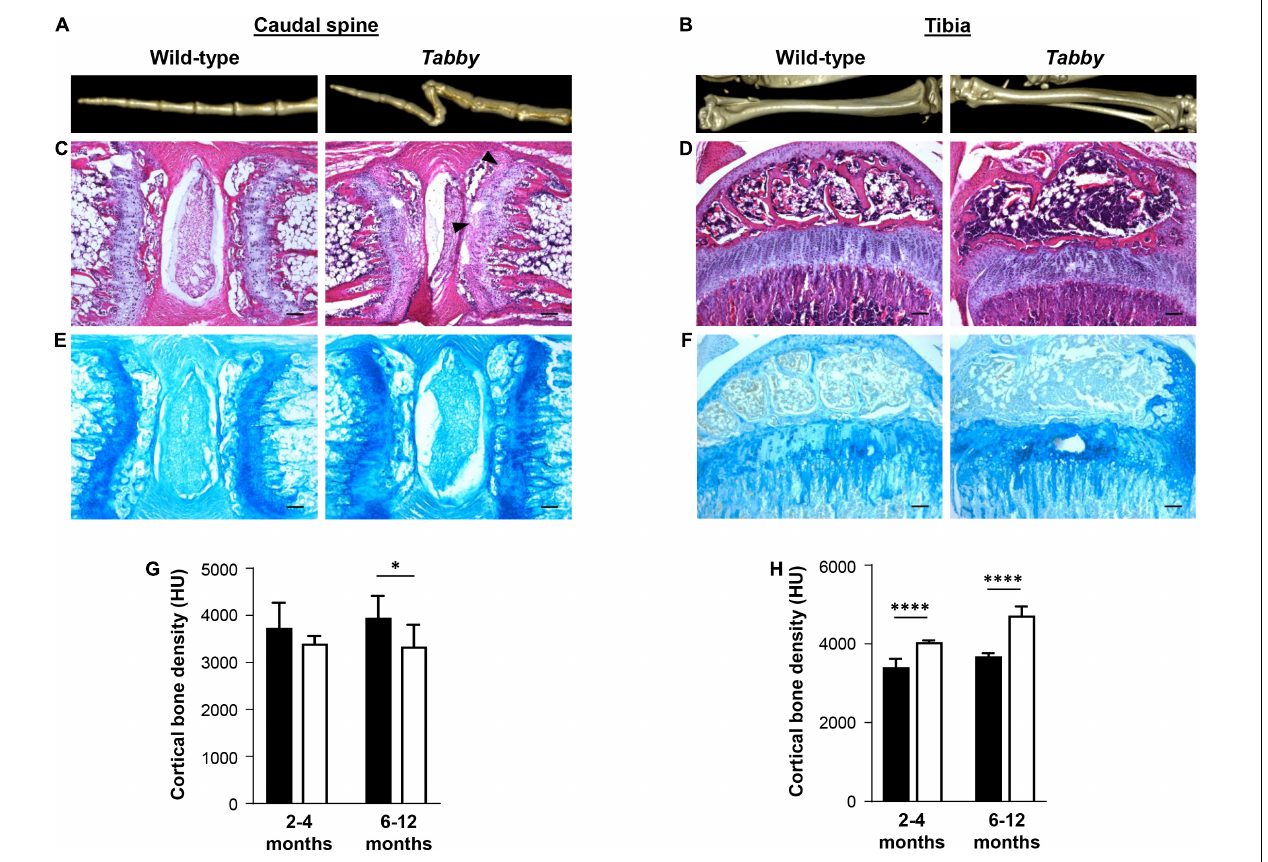
FIGURE 2 | Impact of ectodysplasin A1 (EDA1) deficiency on osteogenesis and bone density. (A,B) Representative three-dimensional reconstructions of (A) the distal tail portion and (B) tibiae of wild-type and Tabby mice. (C–F) Vertebral and tibial bone sections stained with hematoxylin-eosin (C,D) or alcian blue (E,F) : The epiphyseal region appears less well organized and contains more cartilage islands (arrowed) in the tails of Tabby mice than in wild-type mice. (G) Although computed tomography scanning (micro-CT) revealed a tendency toward reduced cortical bone density already in tails of Tabby mice at an age of 2–4 months (mean of 7–10 distal vertebrae where the kink is formed; indicated in Hounsfield units), this difference became significant only in Tabby mice older than 6 months ( n = 6; white bars) compared with wild-type animals ( n = 6; black bars). (H) Tibial bones, in contrast, showed a higher cortical density in Tabby mice of both age groups ( n = 6 and n = 7, respectively; white bars) than in wild-type animals (black bars) as determined by micro-CT measurements. Scale bar in panels (C–F) : 100 µ m. Data are shown as mean ± SD; ∗ p < 0.05; ∗∗∗∗ p <